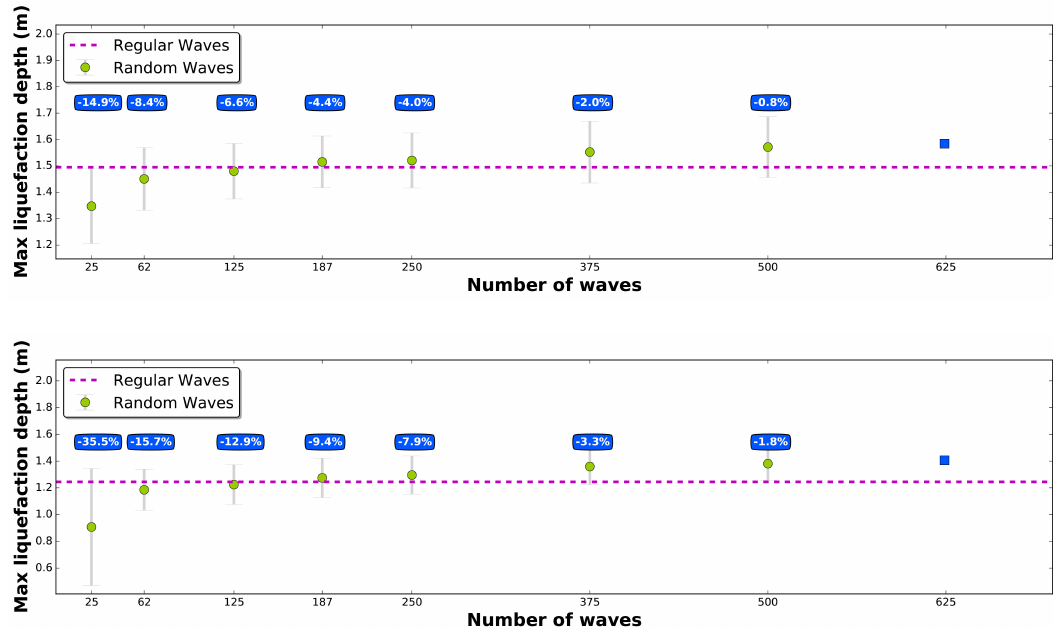
Figure 11. Maximum liquefaction depths as a function of the number of waves. The upper panel refers to submerged berm characterized by h b / h t = 0.19, L b / L w = 0.35. The lower panel refers to a submerged berm characterized by h b / h t = 0.59, L b / L w = 0.35. The circles refer to the mean values, and vertical lines depict standard